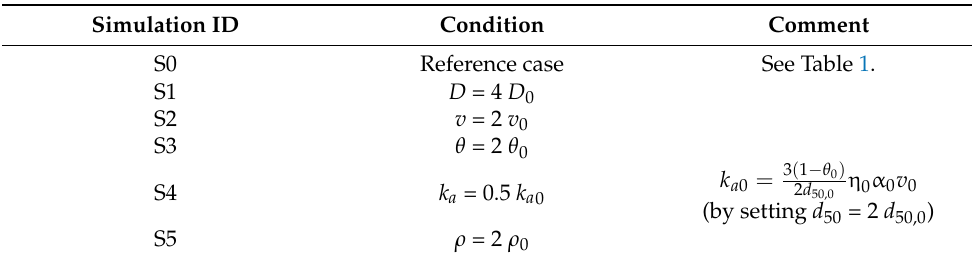
Figure 2. MP transport simulation. Table 2. Simulation